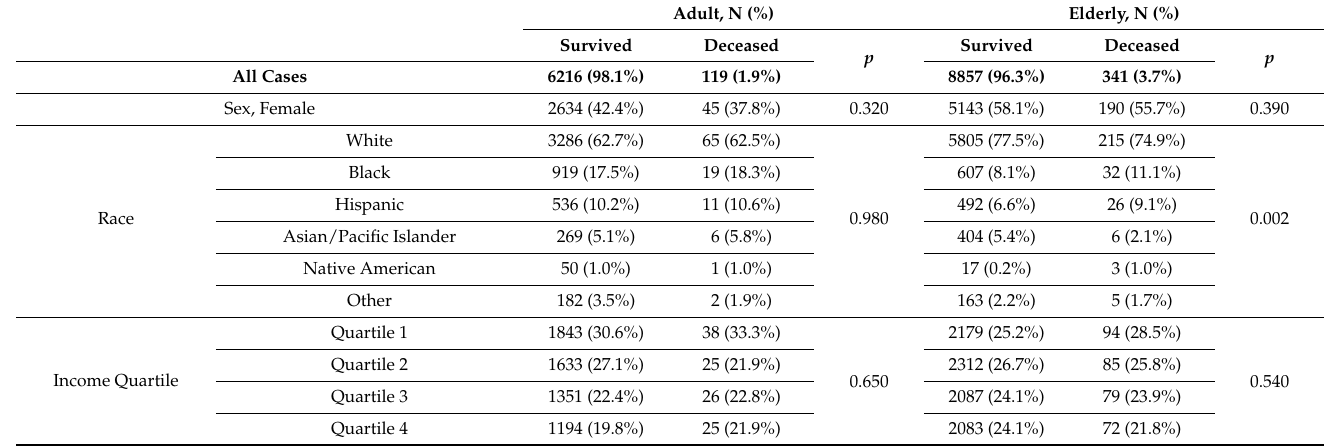
Figure 1. Overall Mortality. Mortality is plotted as a percentage, in relation to three subtypes of ulcers in both the adult group and the elderly group. The three subtypes of ulcers include: only hemorrhagic ulcer, perforated ulcer, and both. An asterisk (*) indicates significance ( p < 0). Table 2. The data presented in this table display the stratification of all emergently admitted gastric ulcer patients based on mortality. These data were supplied by NIS 2005–2014.